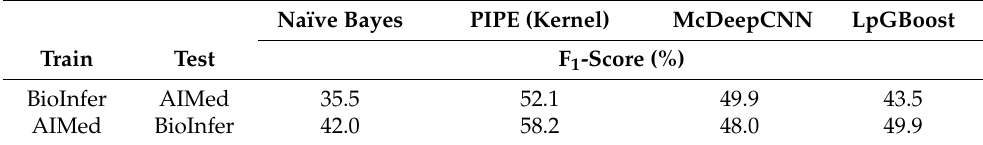
Table 4. Cross-corpus evaluation of PPI datasets.